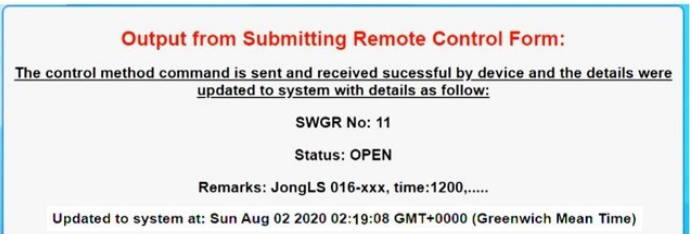
Figure 16. Sample output from the remote-control web after a control command is sent.